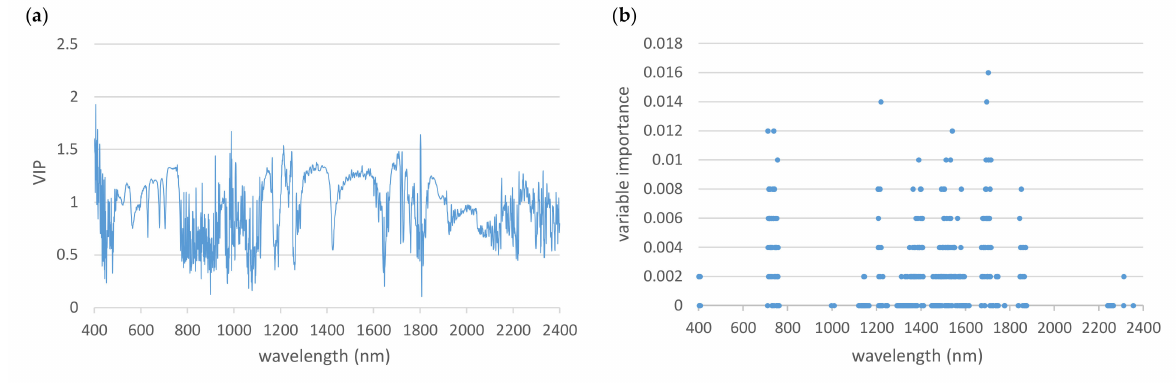
Figure 9. Variable importance for first derivative reflectance computed by PLSR ( a ), and random forest regression (RFR) based on Spearman correlation-selected variables ( b